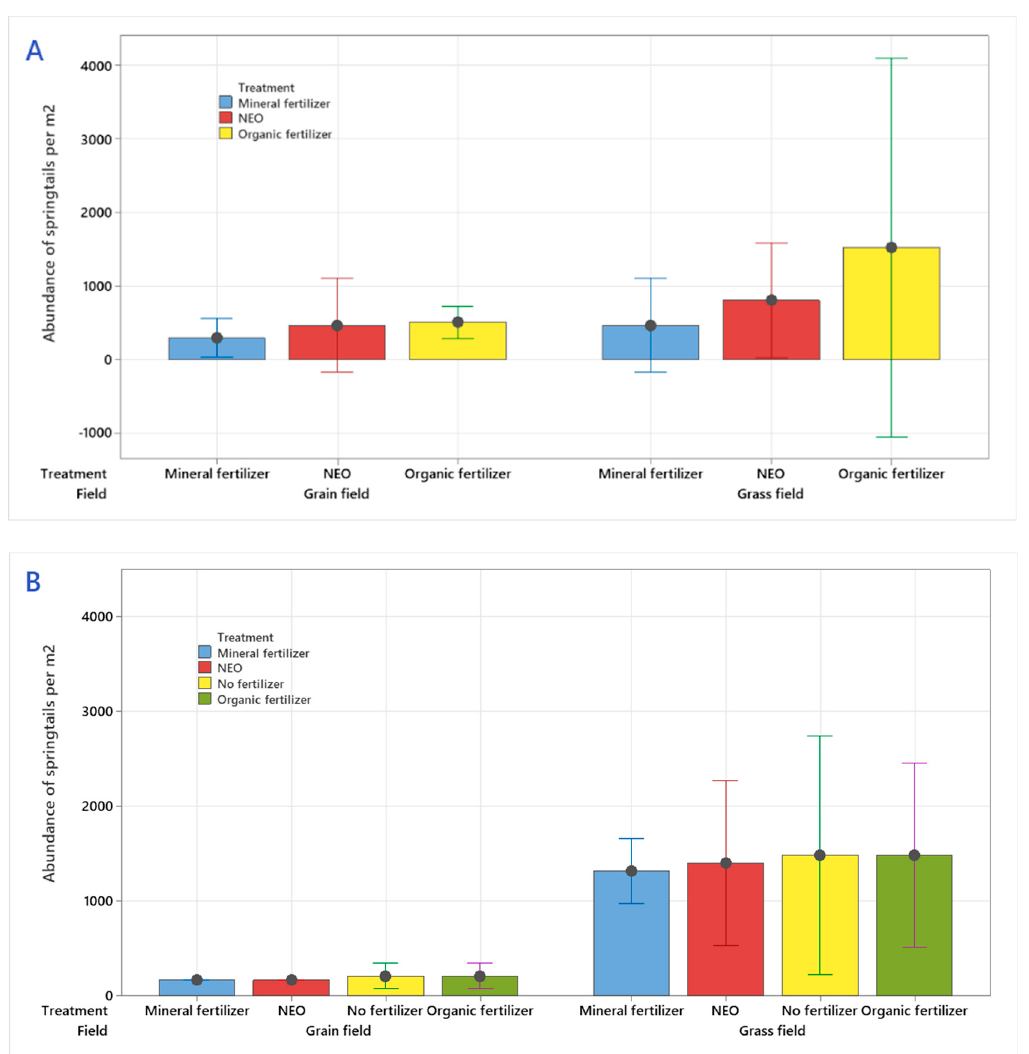
Figure 3. The effect of different fertilization treatments on the abundance of springtails per m 2 in ( A ) summer and ( B ) fall samplings. Error bars are individual standard deviations at a 95% confidence interval.